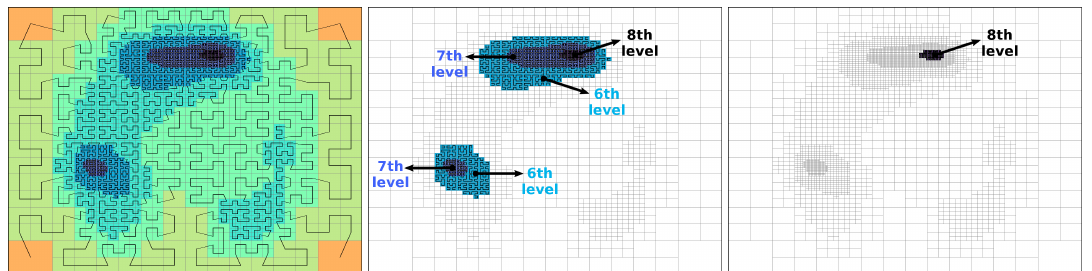
Figure 8. Space-Variant Region of Interest (sROI) in a quad-tree scheme at the 2nd ( left ), 6th ( middle ), and 8th ( right ) minimum refinement levels (MRLs). Each level is represented in a distinct color. In this case, the lowest MRL is the 2nd, meaning that at least two recursive refinements were performed for any of the four points of the initial curve. The 2nd MRL therefore includes all points of the model. Nevertheless, the highest refinement level of the depicted model is the 8th one. Thus, the 6th MRL comprises the points at the 6th, 7th, and 8th refinement levels, whereas the 8th MRL includes only the points of its own level.